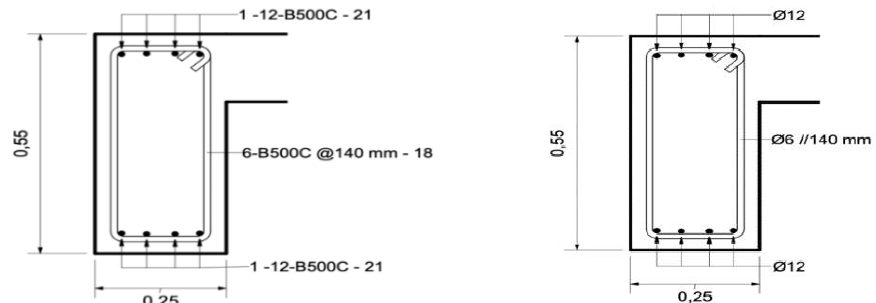
Figure 19. Example of a drawn part before and after changing the annotation family.